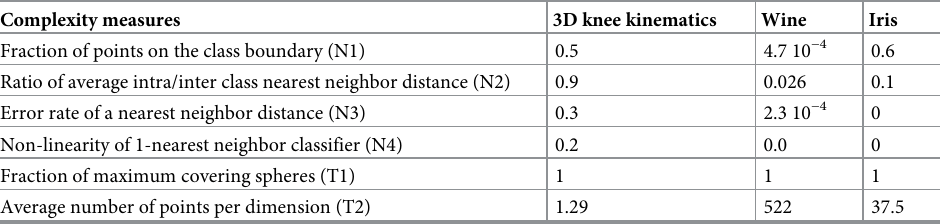
Table 6. Complexity metrics of 3D knee kinematics and reference databases. Complexity